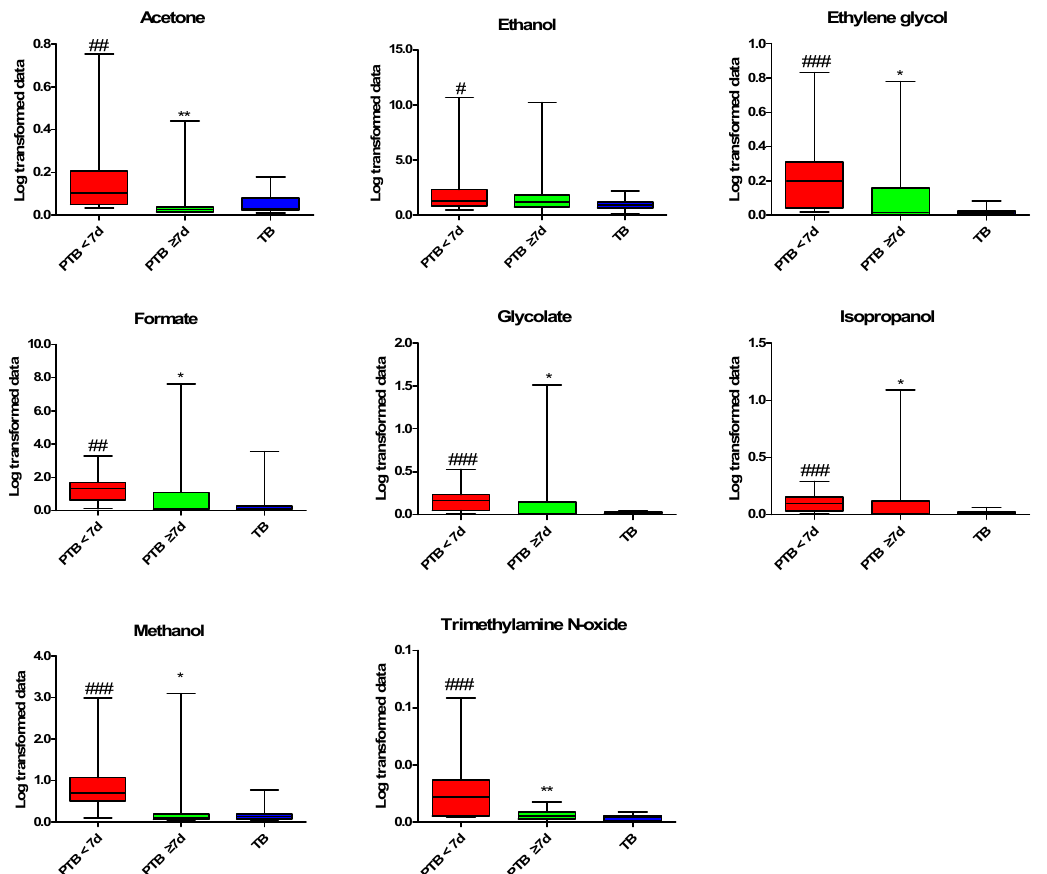
Figure 2. Increased metabolites profiling in CVF samples. Kruskal–Wallis test was used for statistical analysis. The PQN Log-transformed data were used for graphical representation. Data are presented as the mean ± standard deviation, and p < 0.05 considered as significant. #: PTB < 7 d vs. TB; *: PTB < 7 d vs. PTB ≥ 7 d. # p < 0.05, ## p < 0.01, ### p < 0.001, * p < 0.05, ** p < 0.01. PTB: preterm birth; PTB < 7 d: preterm birth less than 7 days after CVF sampling (n = 11); PTB ≥ 7 d: preterm birth more than 7 days after CVF sampling (n = 11); and TB: term birth (n = 21). PQN: Probabilistic quotient normalization.